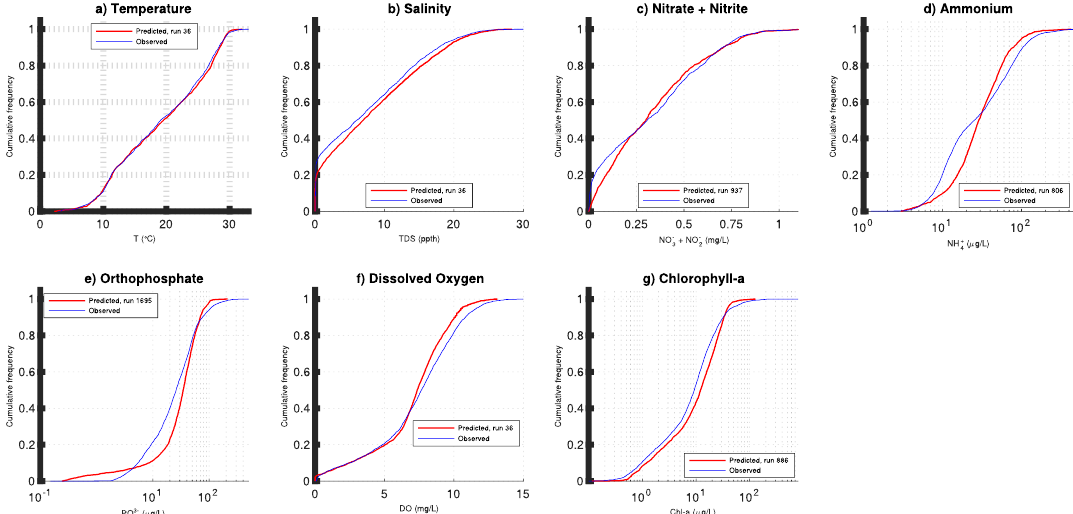
Figure 7. Cumulative frequency distributions for hydrodynamic and water quality variables for 1998–2000 and 2006–2008 combined. Panels show ( a ) temperature, ( b ) salinity, ( c ) nitrate + nitrite, ( d ) ammonium, ( e ) orthophosphate, ( f ) dissolved oxygen, and ( g ) chlorophyll-a